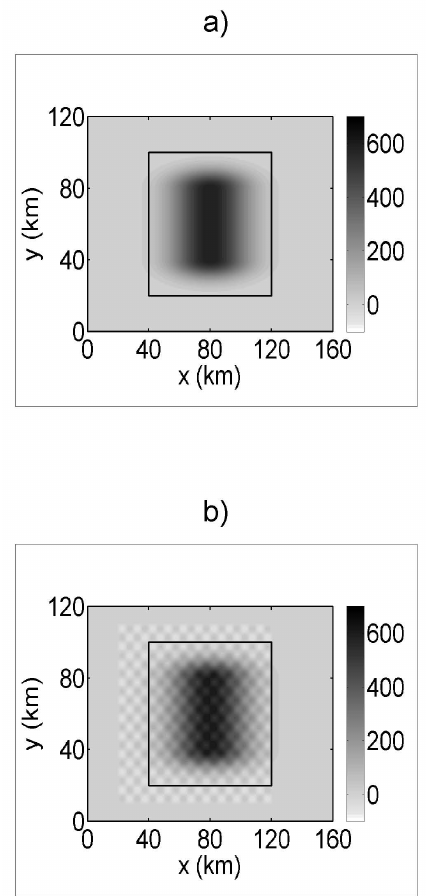
Fig. 1. Horizontal maps of topographic elevation (in meters) for simulations: (a) CTL and (b) Sst10km. The inner black square rep- resents the domain of interest where the scaling analysis computa- tions are